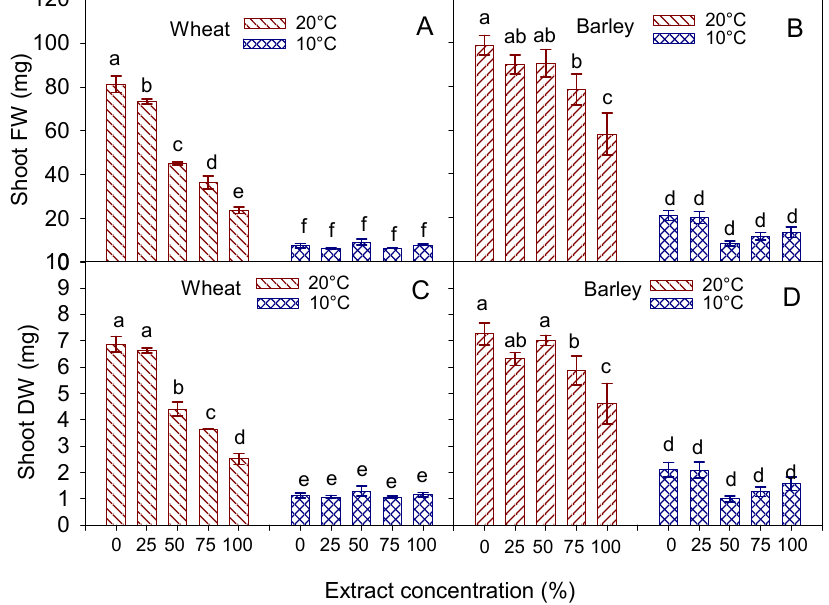
Figure 6. Interaction effect of ‘temperature × extract concentration’ on fresh (FW) and dry (DW) weight of shoot, in wheat cv. Mongibello ( A , C ) and barley cv. Alamo ( B , D ). Data are means ± se ( n = 4). Different letters in barley indicate significance at p < 0.05 according to Tukey’ test.